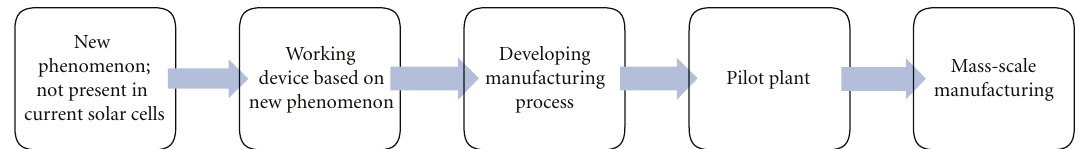
Figure 15: Basic product development and mass-scale manufacturing